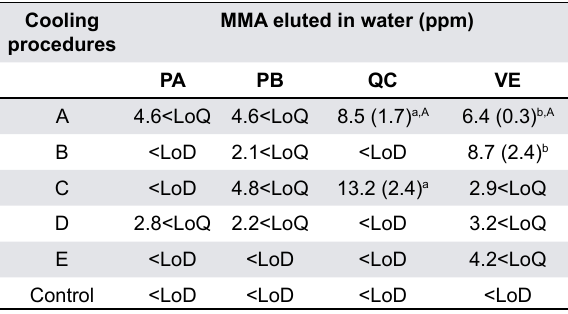
Table 1- The results of the MMA concentration in the water- eluents of the heat-cured PMMA denture base materials tested*